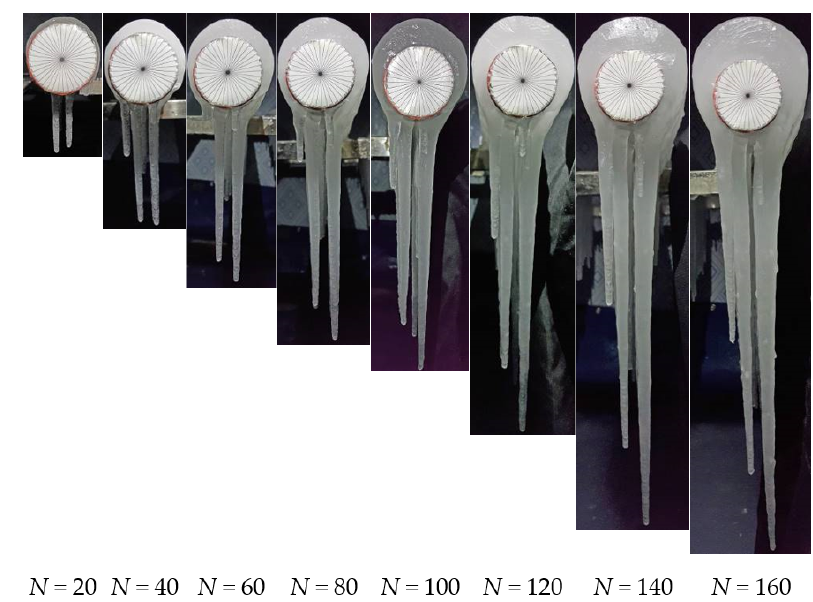
Figure 9. Profiles of ice accretions for various N ( D = 50 mm).